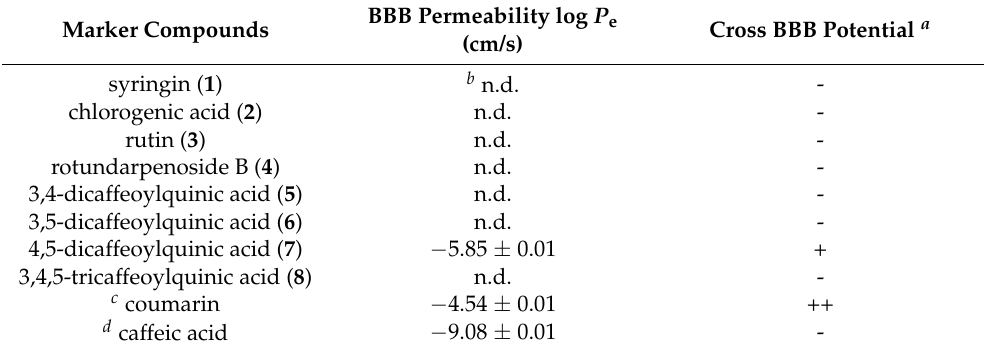
Table 4. Results for BBB permeability of eight marker compounds ( 1 – 8 ) at concentration of 10 mM. Marker